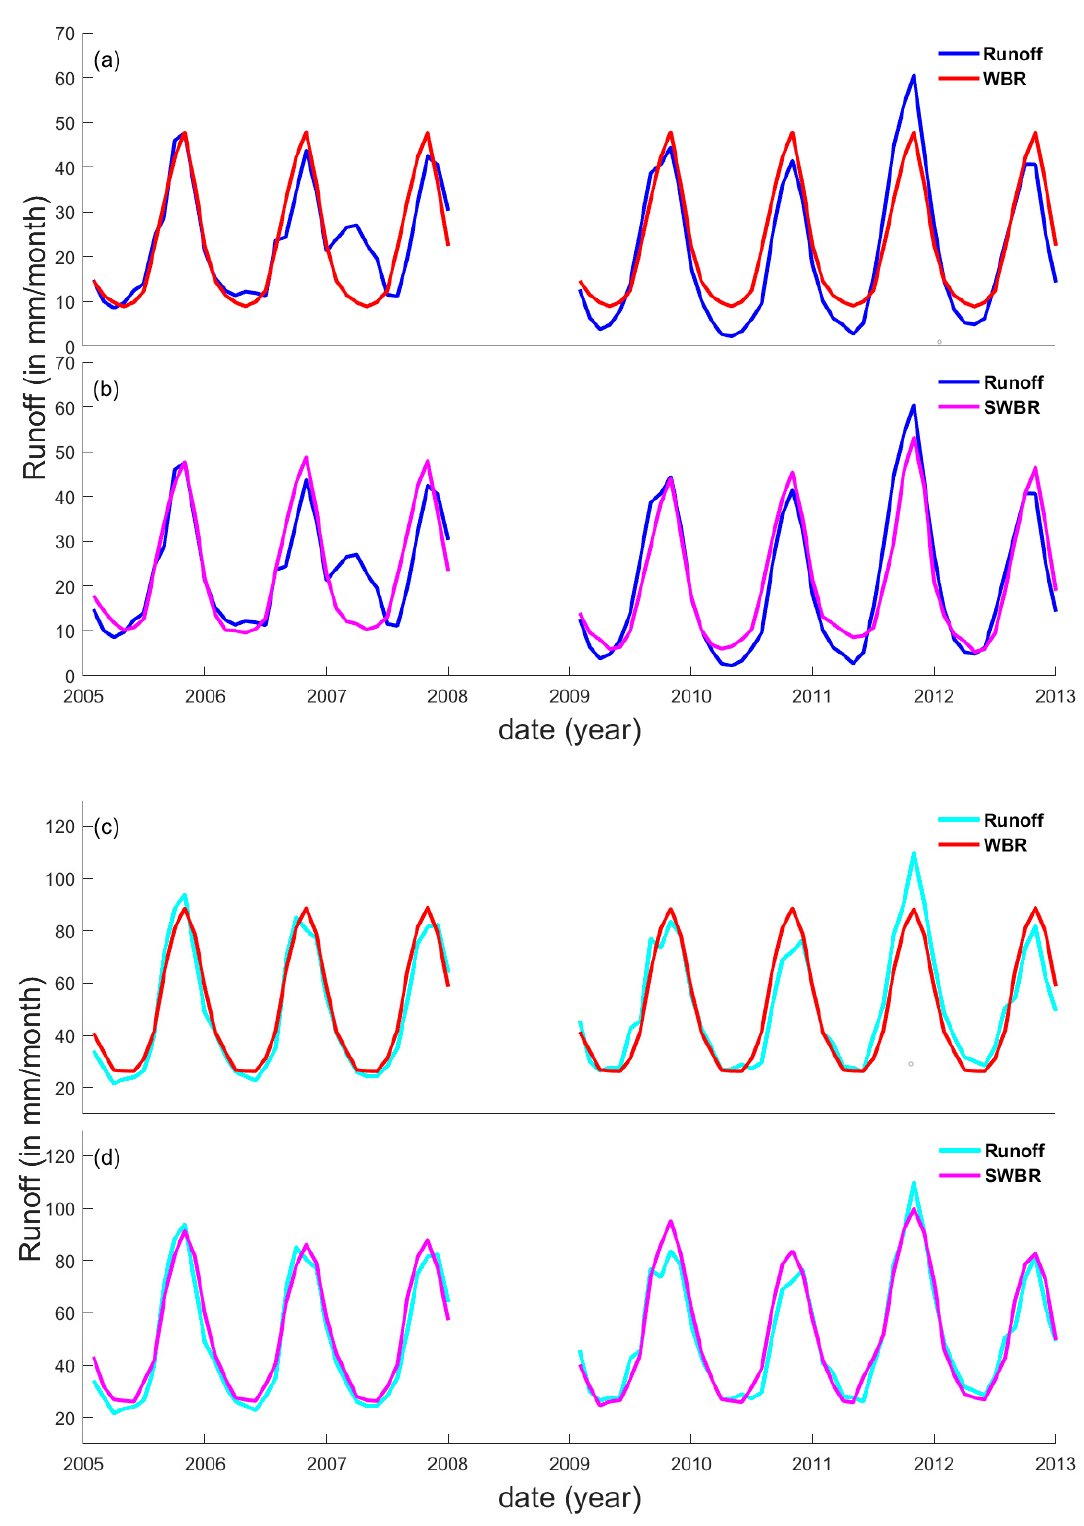
Figure 10. Reconstructed runoff estimates, based on ( a ) and ( c ) water balance equation (WBR) and ( b ) and ( d ) standardized water balance representation (SWBR), calculated from the WBR and its standardized form SWBR at ( a ) and ( b ) My Thuan and ( c ) and ( d ) Tan Chau stations.